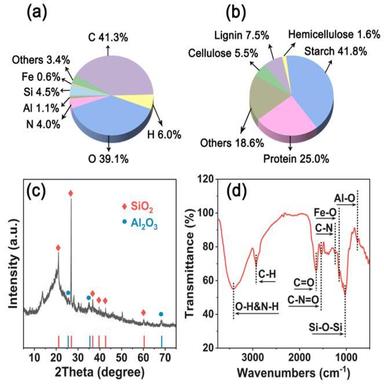
Characterization of FWFR. (a. Element analysis; b. Contents of organic components; c. XRD pattern; d. FT-IR spectrum).